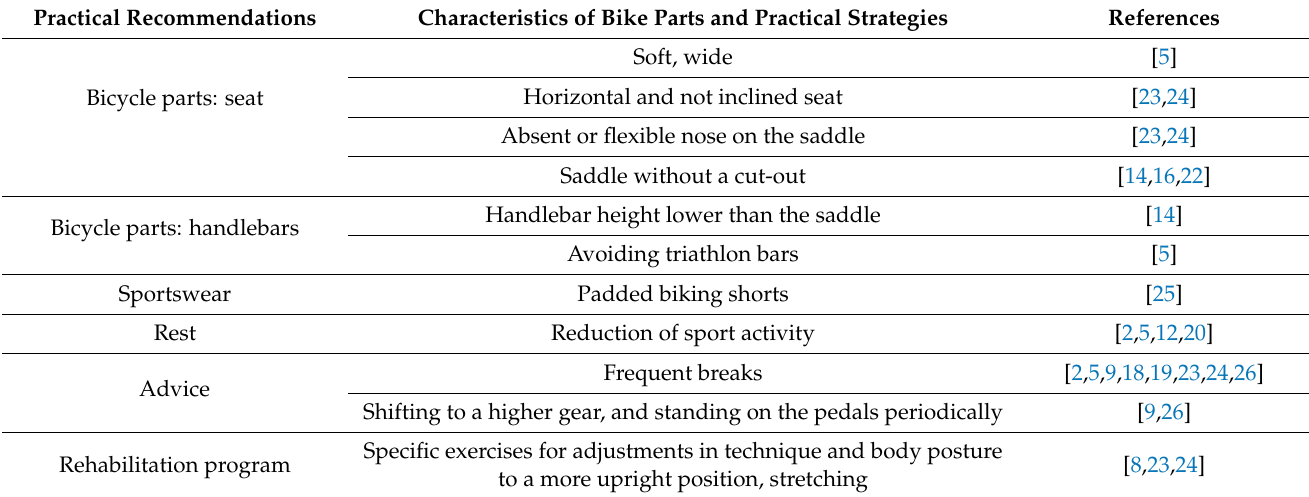
Table 2. Comfortable characteristics of the bicycle and practical recommendations. Practical Recommendations Characteristics of Bike Parts and Practical